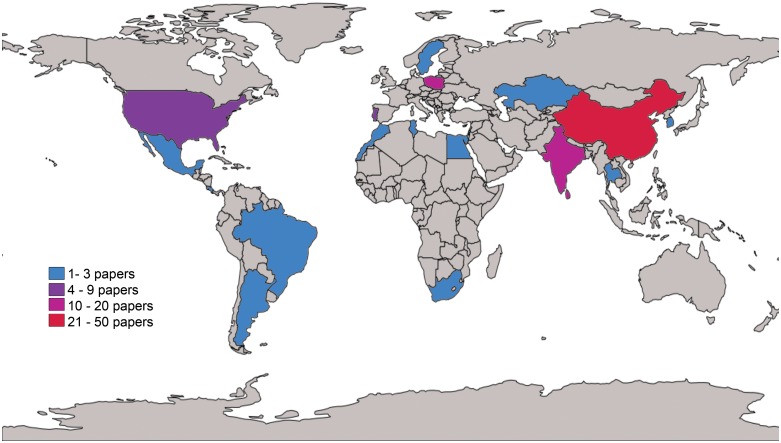
Number of studies reviewed by country.